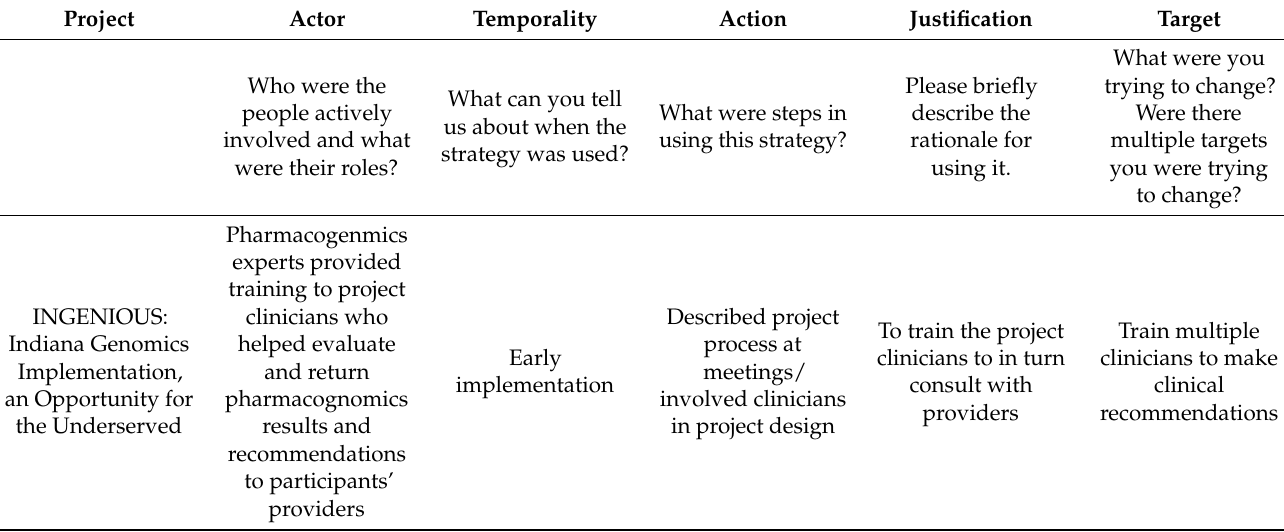
Table 3. Specification of “conducting educational meetings” and “having an expert meet with clinicians” implementation strategies by IGNITE 1 genomic medicine implementation